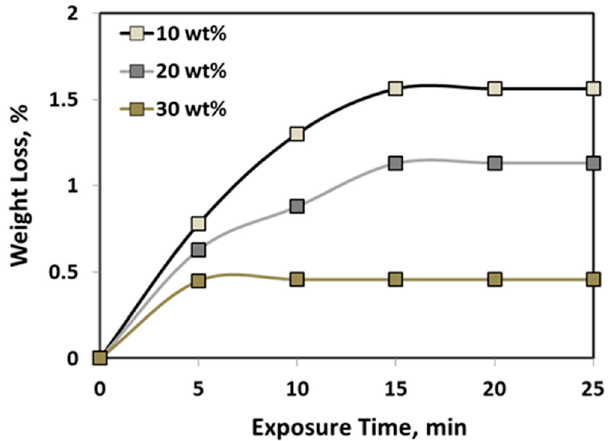
Figure 2. Adhesion test stability for three different washcoat loads.